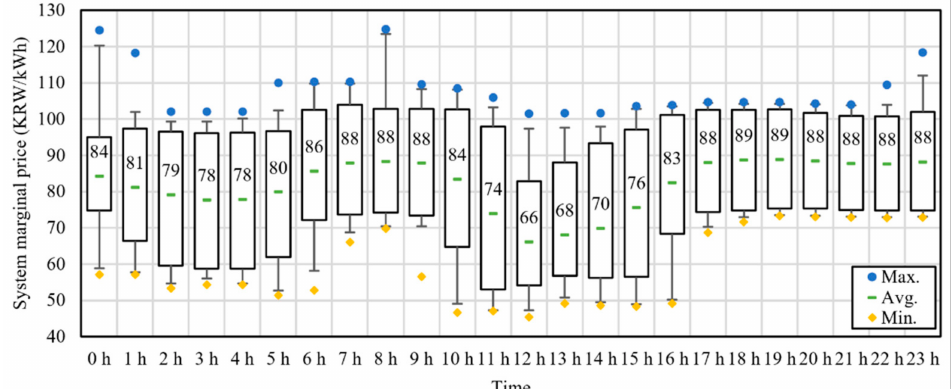
Figure 4. Representative values of system marginal price obtained from market simulation.